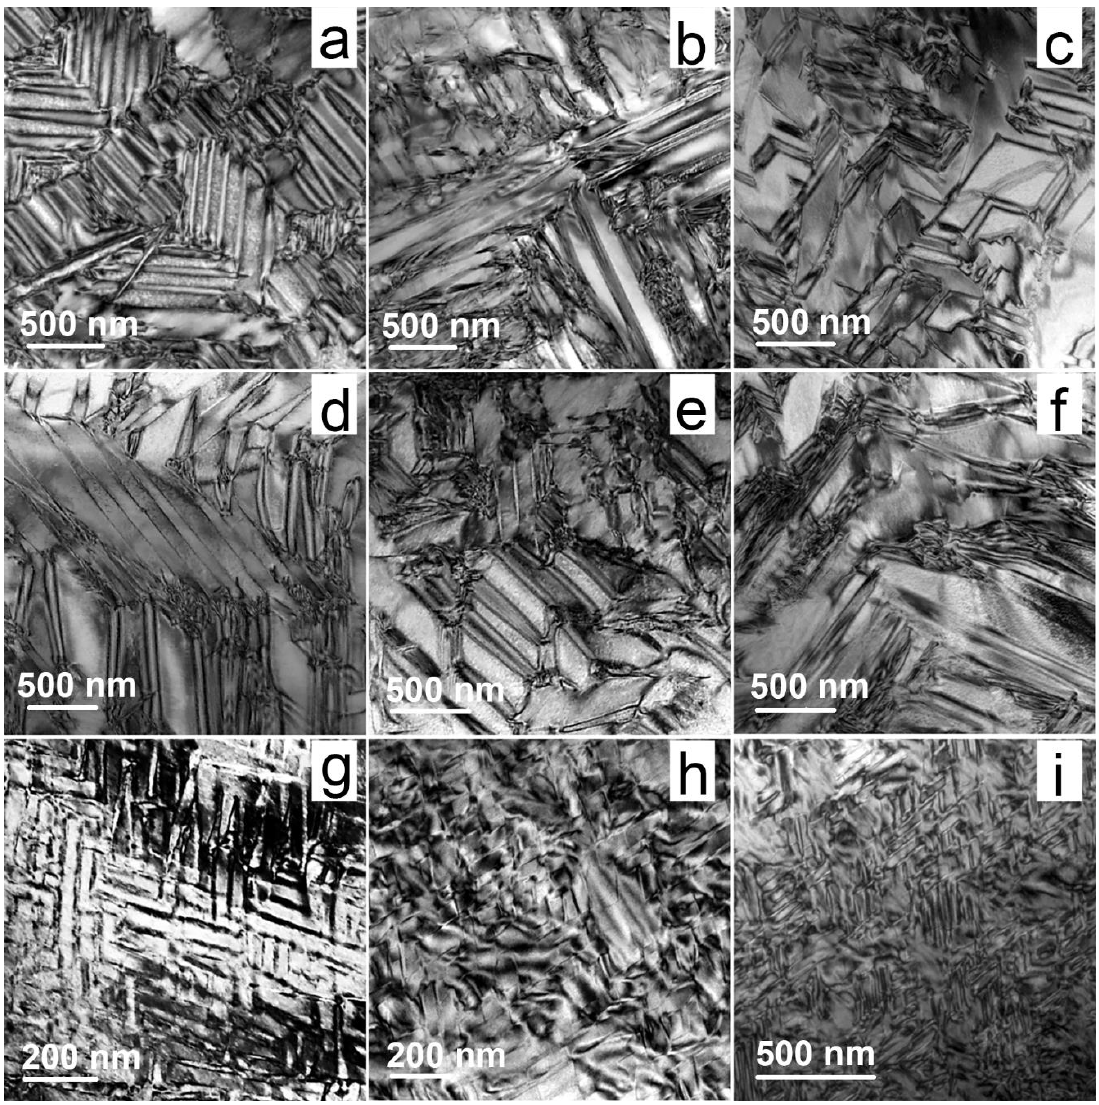
Figure 8. TEM images crystals: ( a ) 2.0Y0.8CeSZ, ( b ) 2.0Y0.8NdSZ, ( c ) 2.0Y0.8ErSZ, ( d ) 2.5Y0.7ErSZ, ( e ) 2.5Y0.7YbSZ, ( f ) 2.5Y0.7TbSZ, ( g ) 2.0Y1.2ErSZ, ( h ) 2.0Y1.2YbSZ and ( i ) 2.0Y1.2TbSZ crystals. Table 2. Microhardness of the test